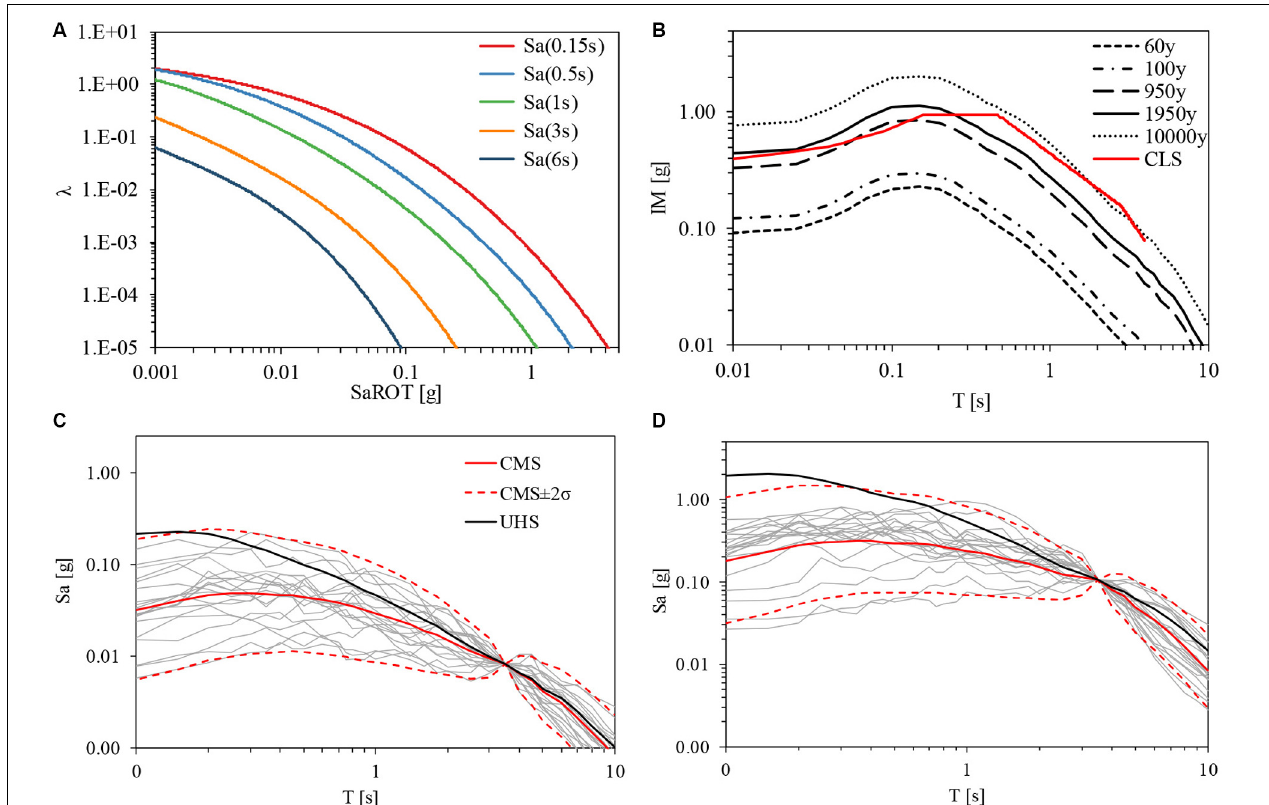
FIGURE 6 | Hazard Curves for the Camerino site with v s = 400 m/s (A) , UHS at different hazard periods (B) , CMS and spectra of the selected set of records for T R = 60 years (C) , and T R = 10000 years (D)